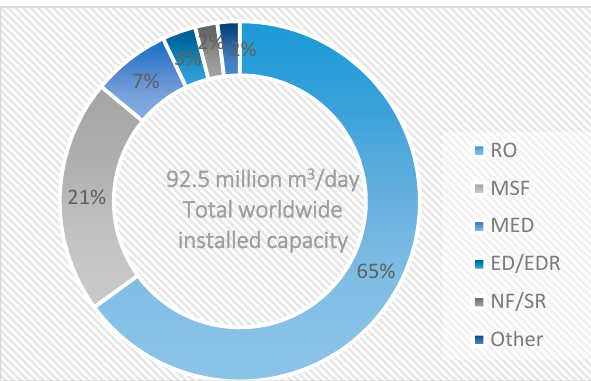
Figure 2. Total global installed capacity by technology type re-drawn from [26].